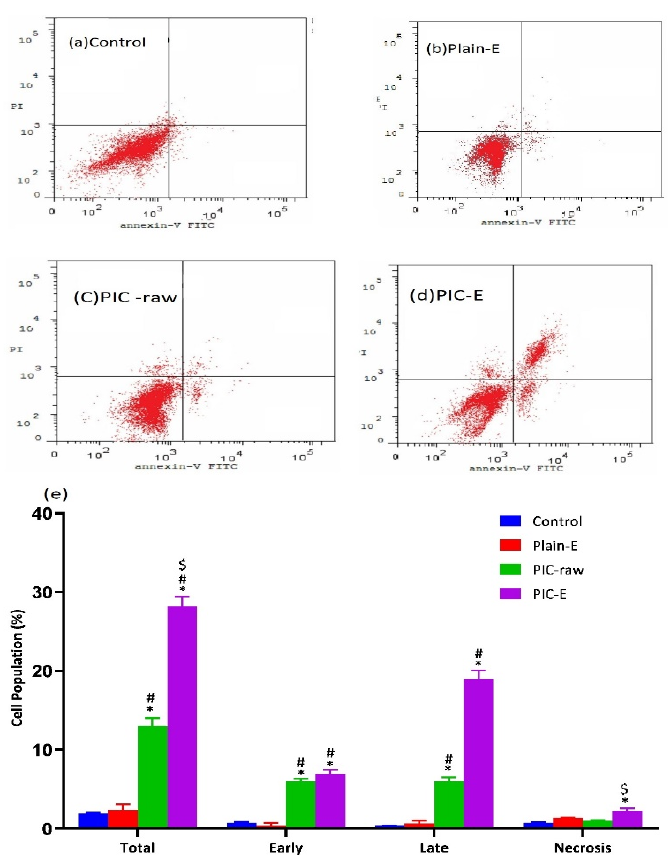
Figure 7. Effect of PIC-E on apoptotic and necrotic death in HCT 116 cells and impact of PIC-E on cell cycle phases of HCT 116 cells: (a) Control, (b) Plain-E, (c) PIC-raw, (d) PIC-E, and (e) bar diagram of different types of cell death. Cells were incubated for 24 h with plain-E, PIC-raw (0.1 µM), or PIC-E (equivalent to 0.1 µM PIC) * Significantly different from control at p < 0.05. # Significantly different from Plain-E at p < 0.05.